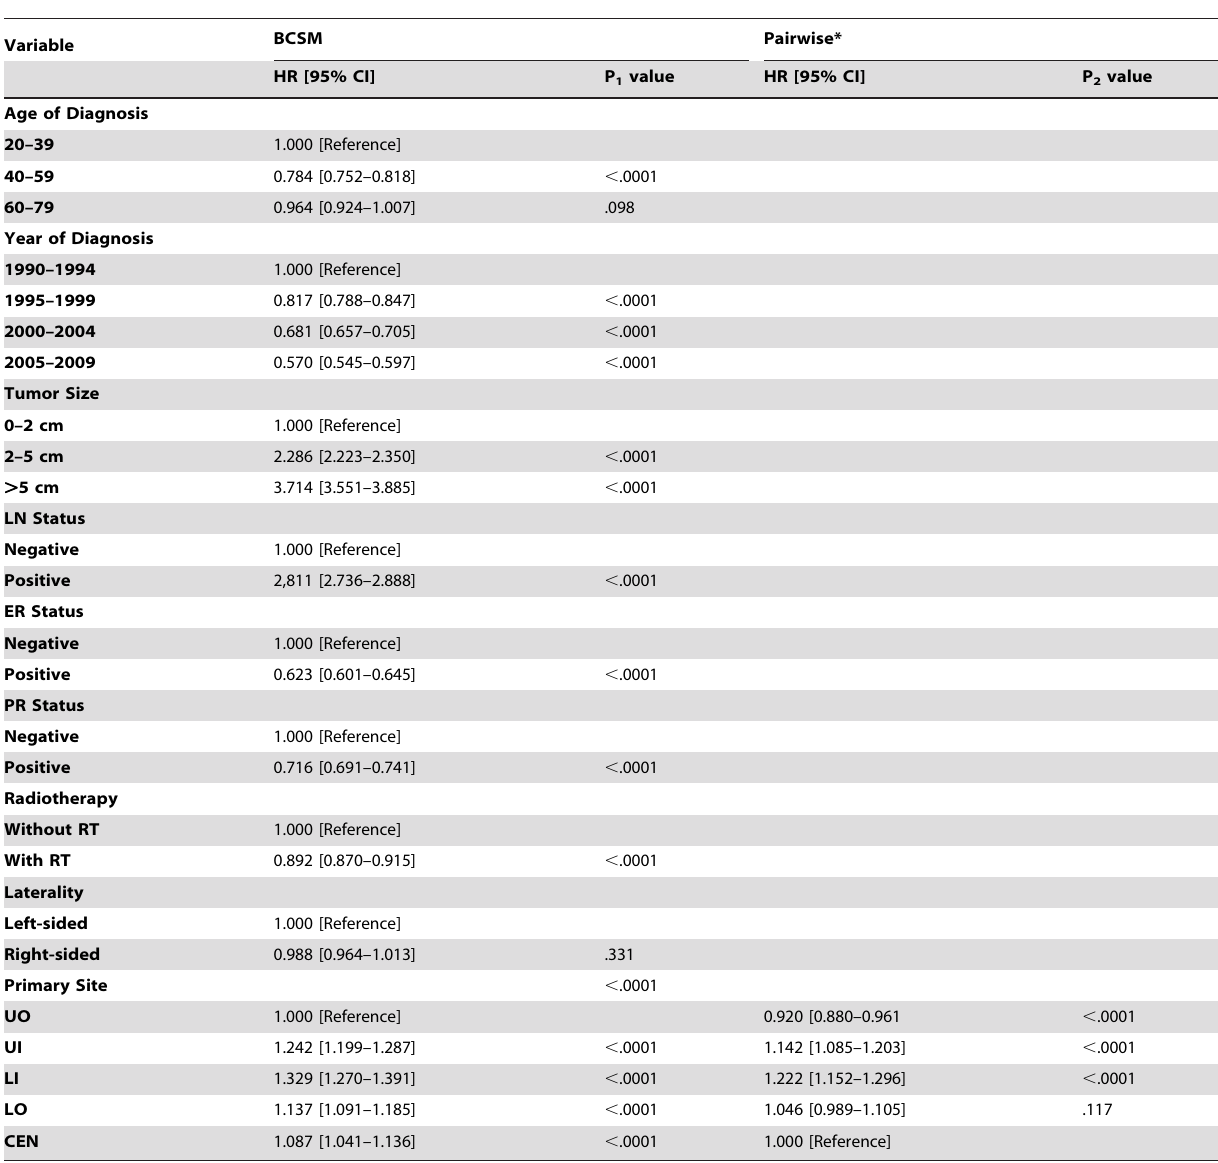
Table 2. Multivariate Analysis of Breast Cancer-Specific Mortality (BCSM).